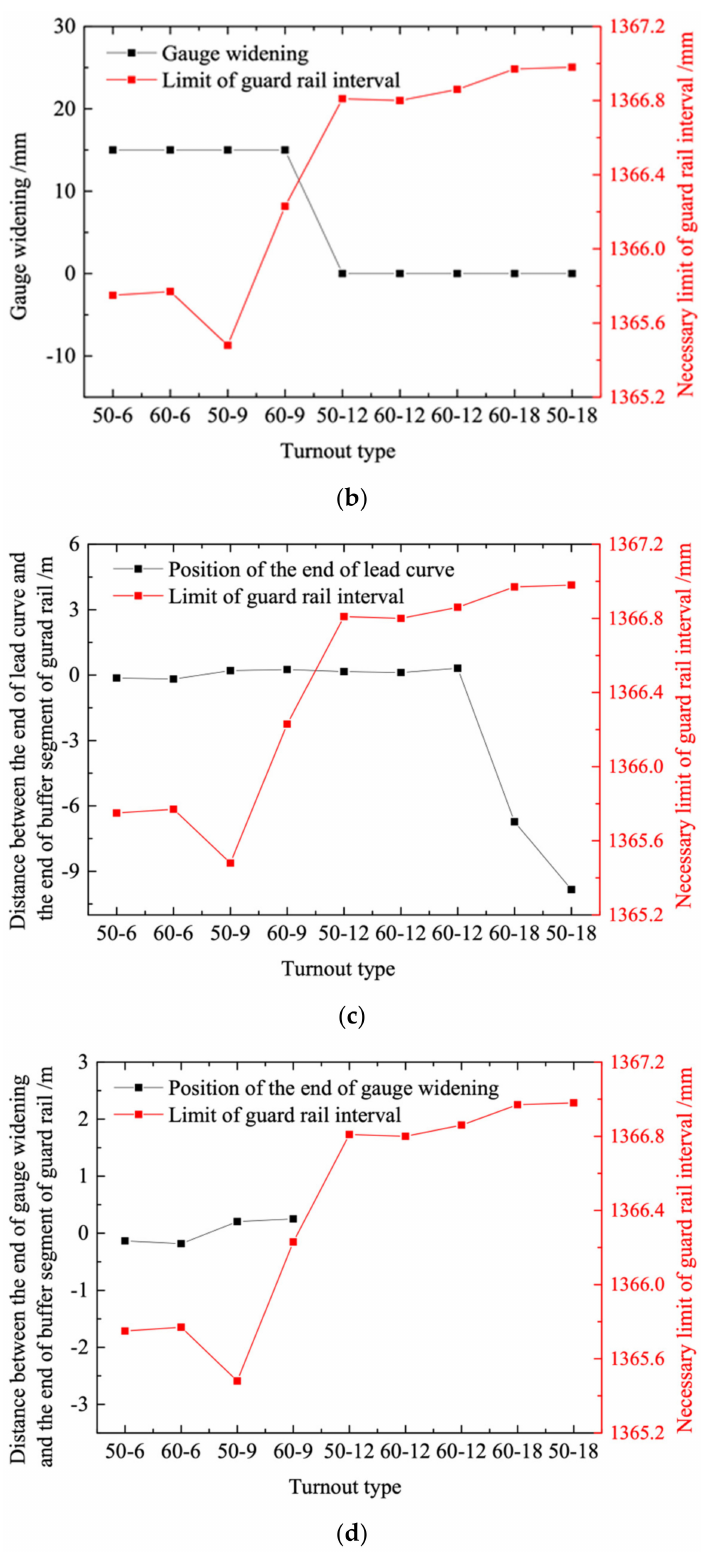
Figure 12. Effect of single turnout alignment parameters on the limit of guardrail interval. ( a ) Radius of lead curve; ( b ) Gage widening; ( c ) Distance between the end of the lead curve and the end of the buffer segment of the guardrail; ( d ) Distance between the end of gage widening and the end of buffer segment of the